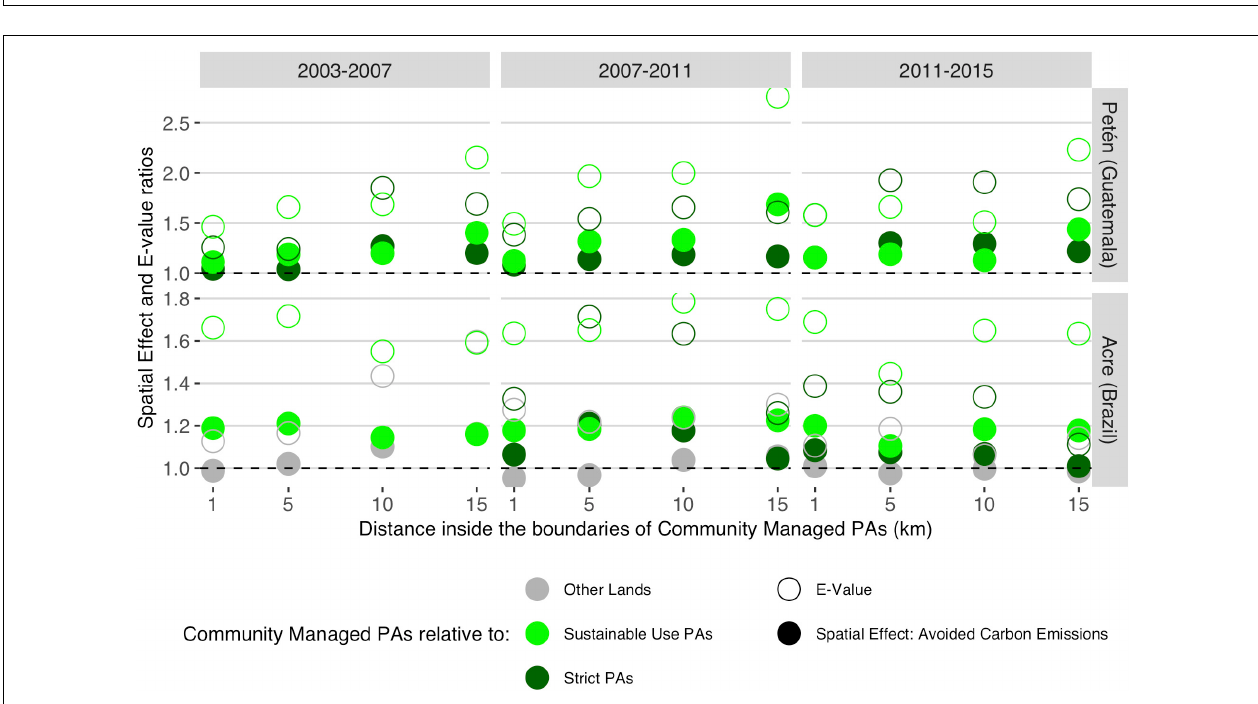
FIGURE 9 | The spatial effects of Community Managed PAs on avoided carbon emissions in Petén (Guatemala) and Acre (Brazil). Positive spatial effects indicate net avoided carbon emissions relative to Other Lands (gray), Sustainable Use PAs (light green), and Strict PAs (dark green). Error bars indicate 95% confidence intervals for temporal effects.